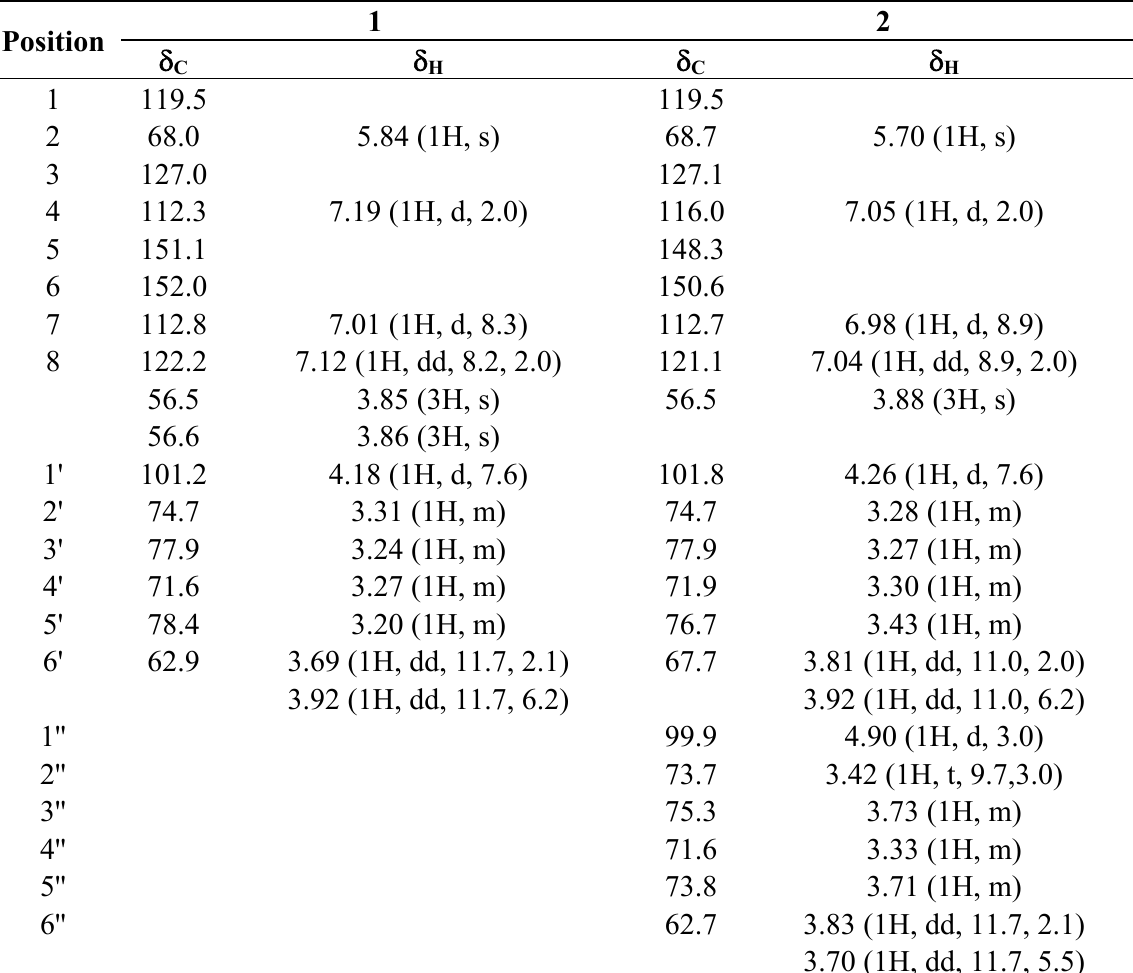
Table 1. 1 H- and 13 C-NMR data of 1 and 2 in CD 600 MHz and 150 MHz,